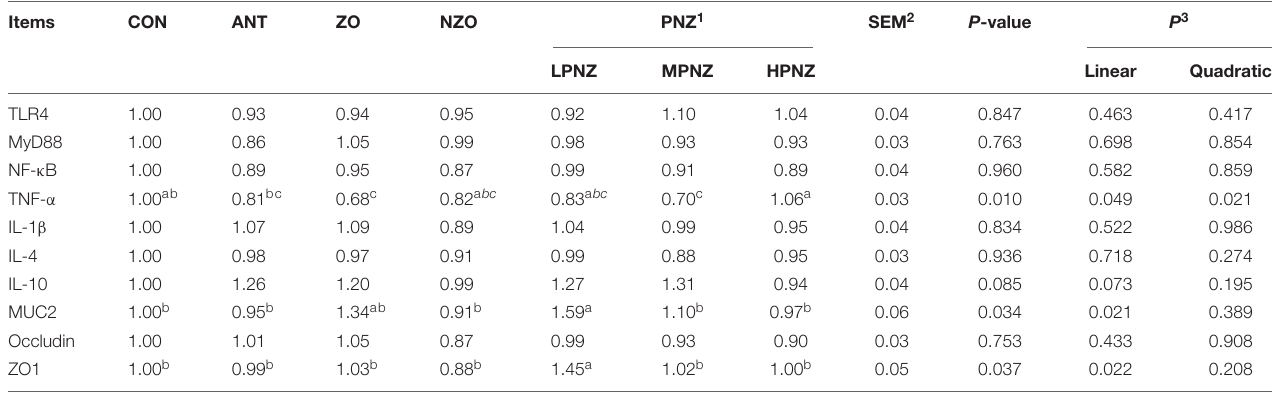
TABLE 7 | Effects of PNZ on the mRNA expression of jejunal mucosa of weaned pigs. Items